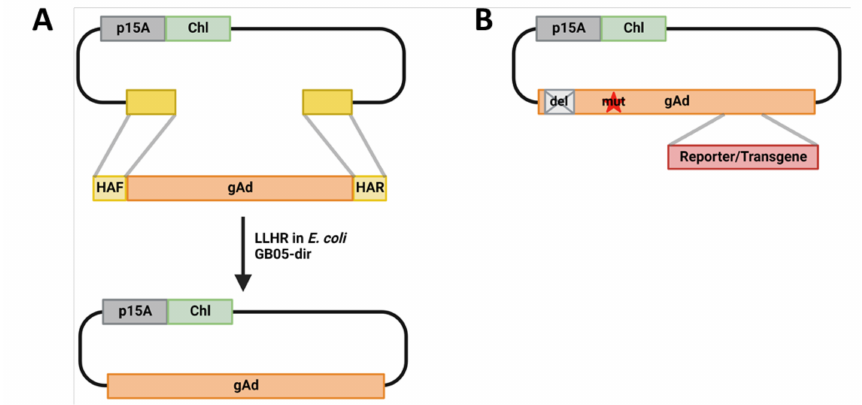
Figure 1. Adenoviral genome cloning and engineering. ( A ). Adenoviral genome direct cloning via linear–linear homologous recombination (LLHR). Adenoviral genome and PCR generated linear plasmid backbone flanked by homologous arms corresponding to the adenoviral genome (gAd) are co-electroporated into the Escherichia coli strain GB05-dir, in which the LLHR generates the adenoviral genome containing plasmid. ( B ). Whole-genome-wide seamless adenovirus engineering exemplified by introduction of mutations, deletions and reporter/transgene insertions. p15A, p15A plasmid origin of replication [13]; Chl, chloramphenicol acetyltransferase , Chloramphenicol resistance gene; gAd, adenovirus genome; del, deletion; mut, mutation. Figures are created with